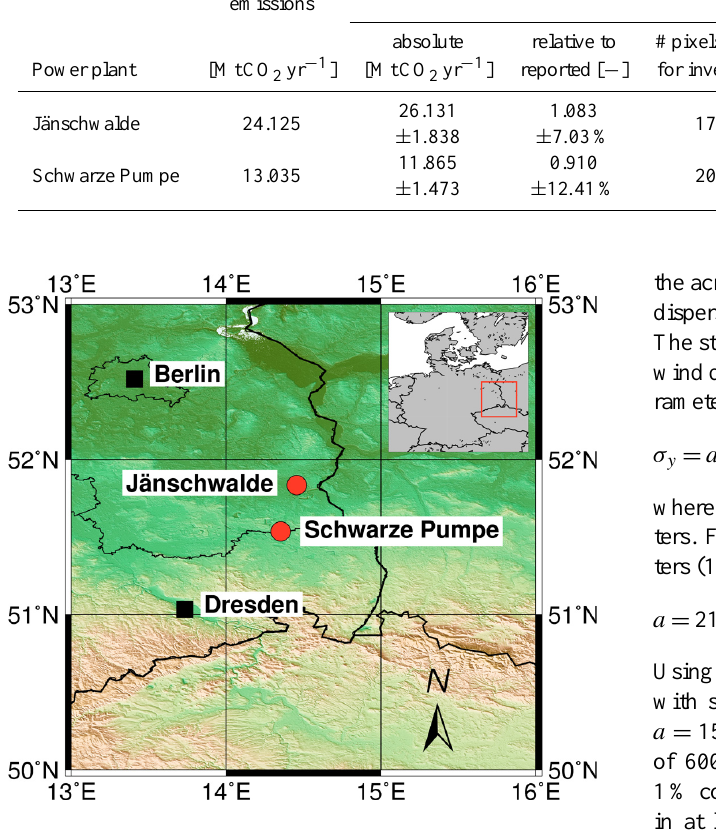
Fig. 2. Map of locations of power plants J¨anschwalde and Schwarze Pumpe in eastern Germany close to Berlin. The dis- tance between the two power plants is about 35km. (Topographic data has been obtained from the Shuttle Radar Topography Mis- sion (SRTM) version 2.1 (http://dds.cr.usgs.gov/srtm/version2 1/), a collaborative effort from NASA, NGA as well as the German and Italian Space